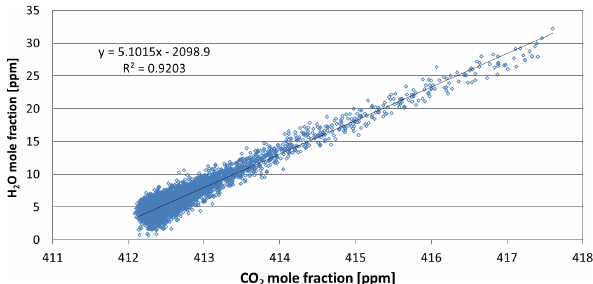
Figure 2. Emptying experiment within 14h: CO 2 mole fraction of a steel cylinder vs. its pressure is shown in red (only every 100 point of 0.1s resolution data is shown). The Langmuir monomolec- ular layer desorption model is shown in blue (CO 2 , ad = 0.41ppm, K = 0.0436bar − 1 ) .